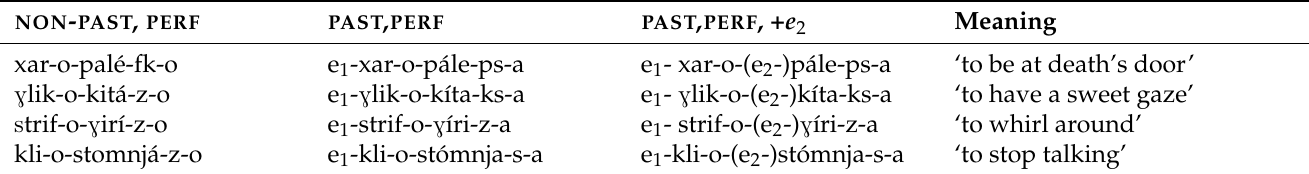
Table 5. Verbal complexes with three-syllable verb